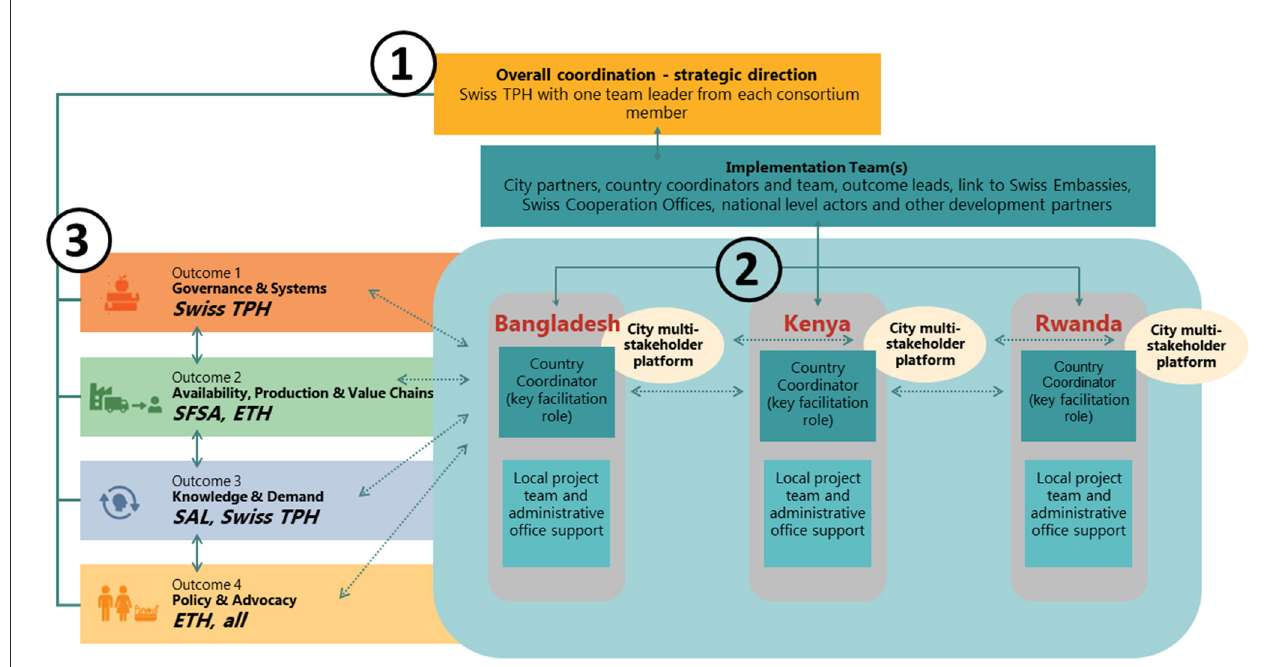
FIGURE3 Overall set-up of NICE. NICE is set-up around 3 levels of governance: (1) overall coordination and steering of the project by a leadership board consisting of the team leader from Swiss TPH and one team leader from each consortium member; (2) country-led implementation through country-level project coordinators and their teams consisting of city-based coordinators as well as assisting staff; (3) cross-cutting technical support and quality assurance across cites and countries by global outcome teams bringing in the specific expertise of all four consortium partners. Swiss TPH, Swiss Tropical and Public Health Institute; SFSA, Syngenta Foundation for Sustainable Agriculture; ETH, Eidgenössische Hochschule Zürich; SAL, Sight and